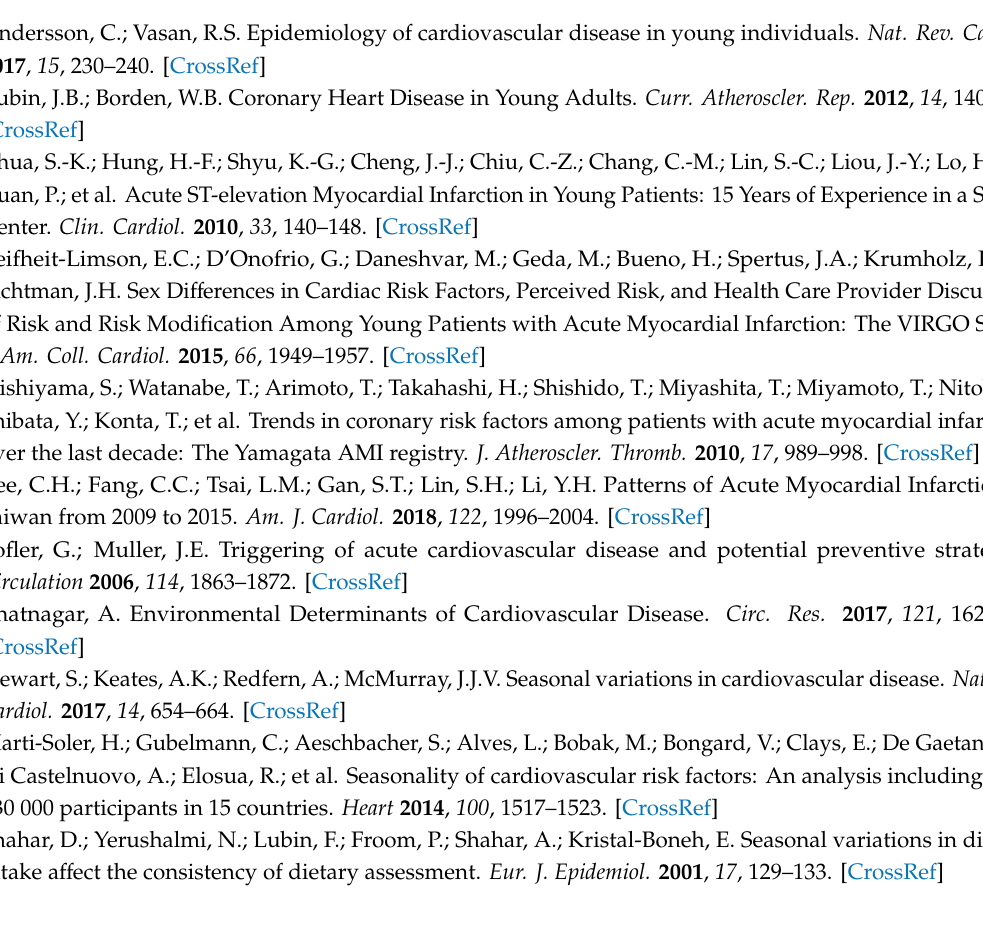
Table S1: Comparison of clinical characteristics between the included cases and the excluded